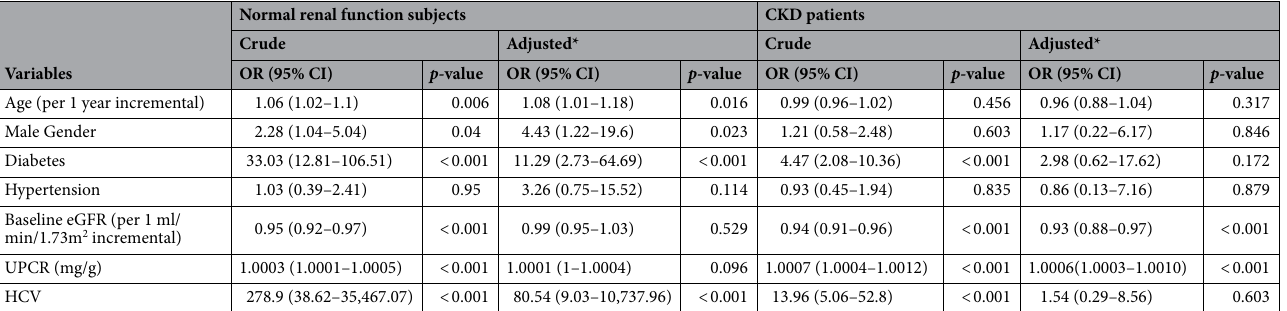
Table 3. Risks for the 50% decline in eGFR from the baseline value at 3-year of follow-up. CKD chronic kidney disease, eGFR estimated glomerular filtration rate, HCV hepatitis C virus, OR odd ratios, UPCR urine protein to creatinine ratio. *Adjusted for age, gender, hypertension, diabetes mellitus, baseline eGFR, and